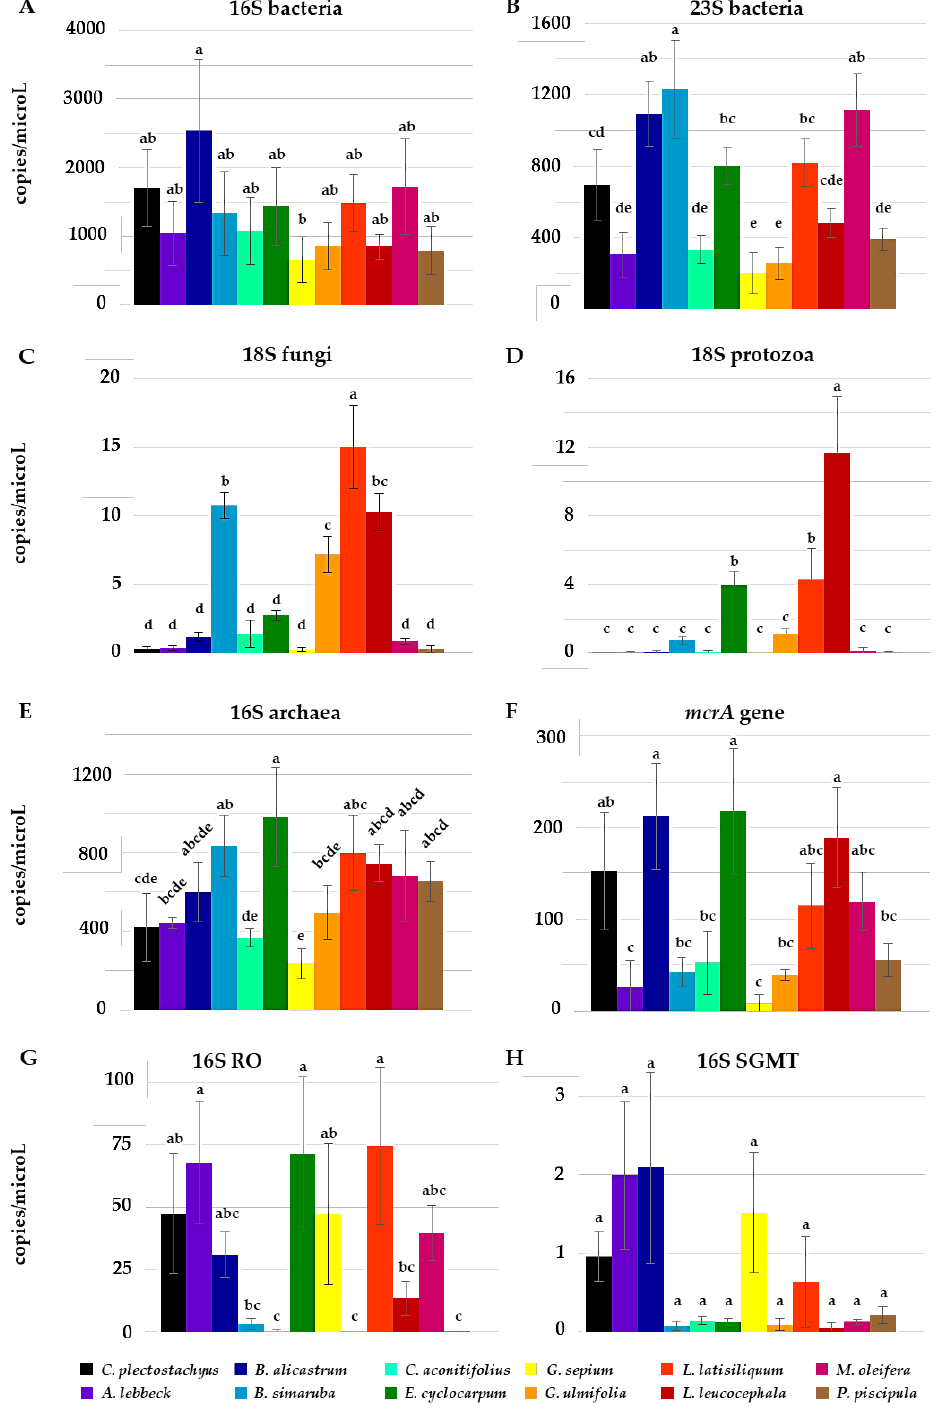
Figure 1. Foliage of tropical trees and shrubs modify the ruminal microbiota during in vitro fermentation. The four main ruminal microbial populations were quantified with primers for 16S and 23S of bacteria (( A ) and ( B ), respectively), 18S of fungi ( C ), 18S of protozoa ( D ) and 16S of archaea ( E ). Archaea subgroups were evaluated with the methyl co-enzyme M reductase alpha subunit ( mcrA ) gene ( F ) and with clade specific primers for Methanobrevibacter sp. subgroups RO ( M. ruminantium , M. olleyae ) and SGMT ( M. smithii , M. gottschalkii , M. millerae , M. thaueri ) (( G ) and ( H ), respectively). Color bars represent each of the tree and shrub species. a–e Different letters in the same column denote differences ( p <